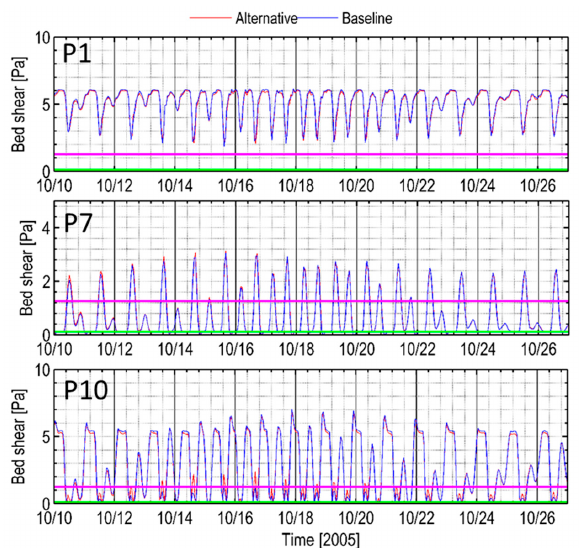
Figure 16. Preferred vs. baseline scenarios: time series of bed shear stress at Stations P1, P7, and P10 for bank-full conditions at 750.62 m 3 /s river flow (tides and wind corresponding to October 2005). Critical bed shear for the erosion of sand (0.11 Pa) and gravel (1.26 Pa) is marked as green and pink lines.